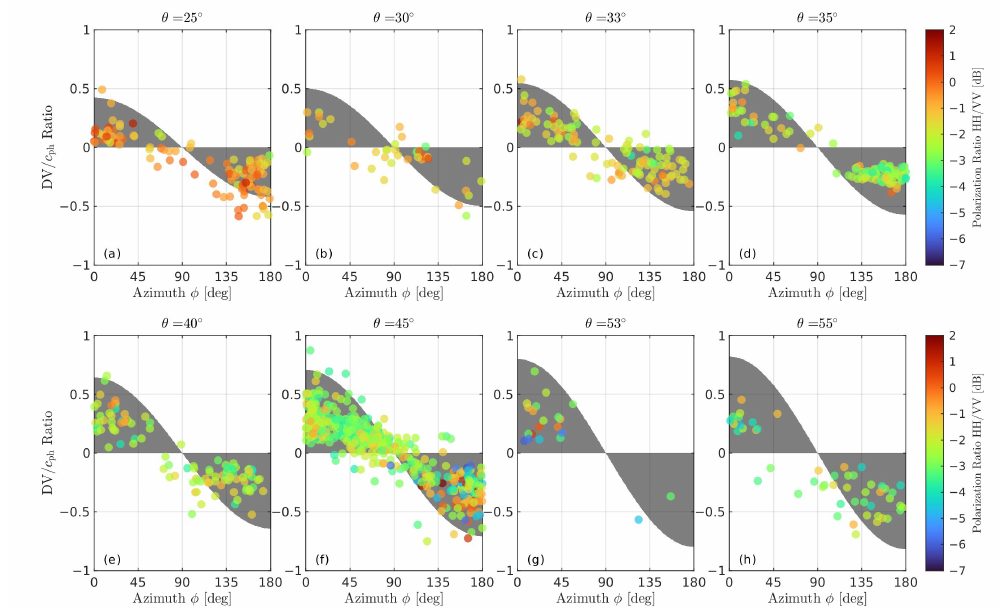
Figure 7. The Doppler velocity (DV) at VV polarization normalized by the breaker phase speed, DV/ c ph , versus the breaker azimuth for different incidence angles: ( a ) θ = 25 ◦ , ( b ) θ = 30 ◦ , ( c ) θ = 33 ◦ , ( d ) θ = 35 ◦ , ( e ) θ = 40 ◦ , ( f ) θ = 45 ◦ , ( g ) θ = 53 ◦ , and ( h ) θ = 55 ◦ . Each point cor- responds to a separate breaking event. The color of the symbols indicates the polarization ratio, HH/VV, in the logarithmic scale. Shaded areas show the limiting speed determined by sin θ cos φ